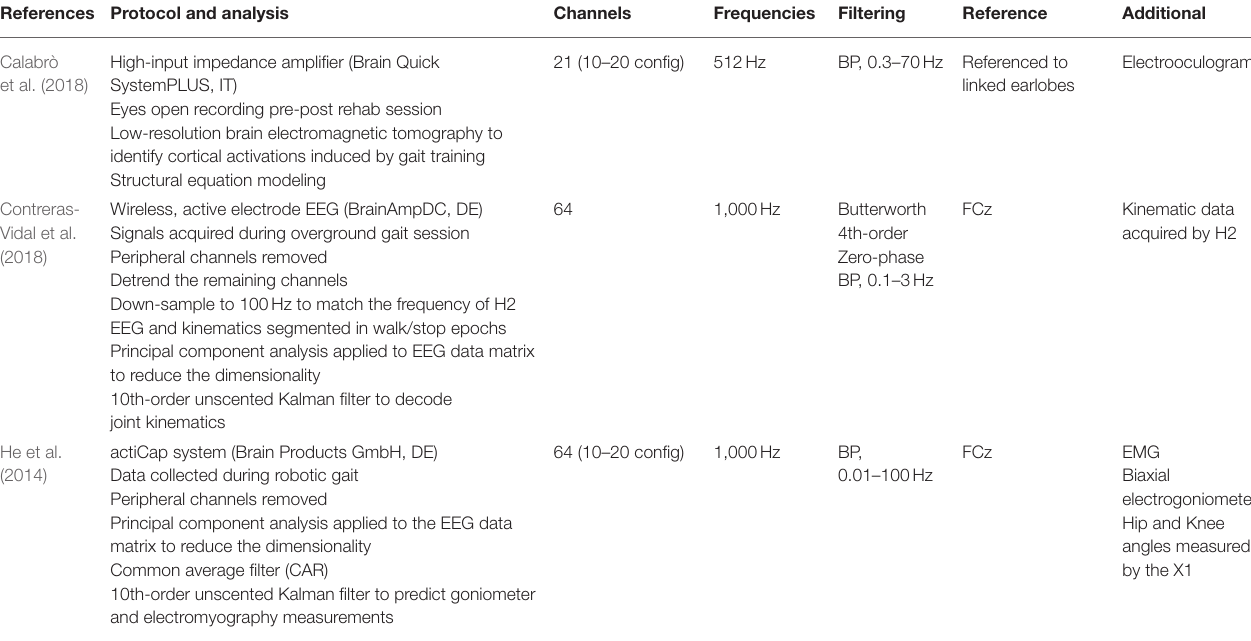
TABLE 3 | Electroencephalography (EEG) signal processing in included